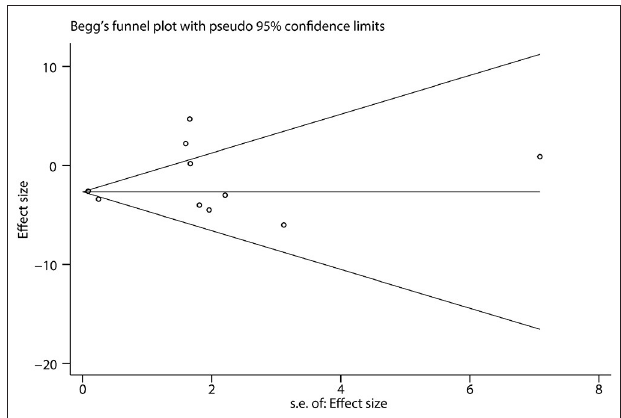
FIGURE 7 | Publish bias analysis. Publish bias was evaluated by Begg’s funnel